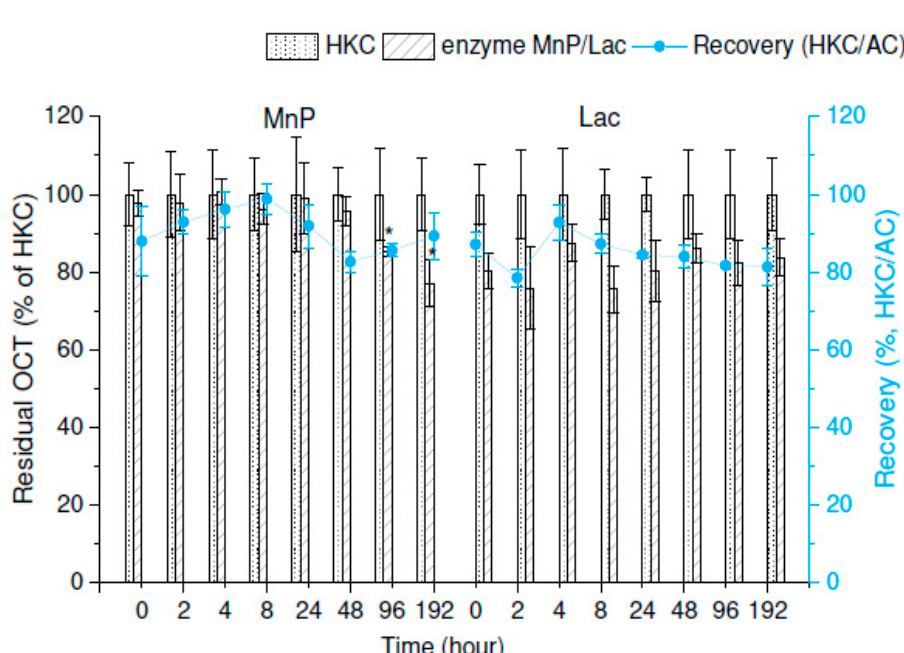
Figure 3. In vitro degradation of octenidine (OCT) in concentrated extracellular liquids of I. lacteus (manganese-dependent peroxidase, MnP) and P. ostreatus (laccase, Lac). Initial concentration of OCT was 5 µg/mL in both experiments. The blue line graphs show the recovery of OCT extraction during the experiment expressed as the heat-killed control (HKC) and abiotic control (AC) ratio. Error bars represent standard deviation ( n = 3). The asterisk marks a significant difference between the individual harvesting day and the control group—0 d (post-hoc Dunnett’s Test).